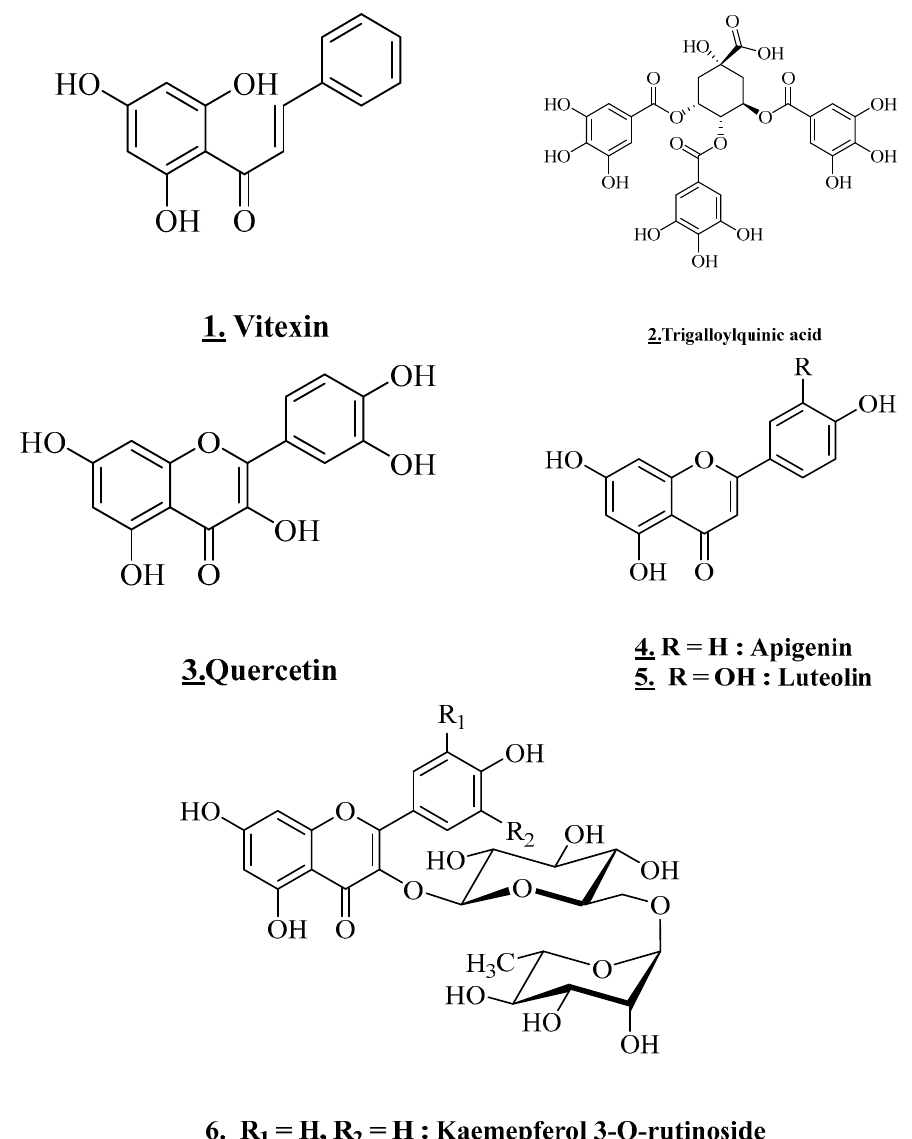
Figure 3. Structures of the main flavonoids , ( 1 ), ( 2 ), ( 3 ), ( 4 ), ( 5 ), ( 6 ), ( 7 ) , ( 8 ).